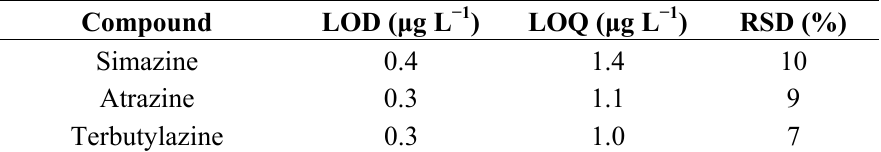
Table 3. Detection limit (LOD), quantification limit (LOQ) and relative standard